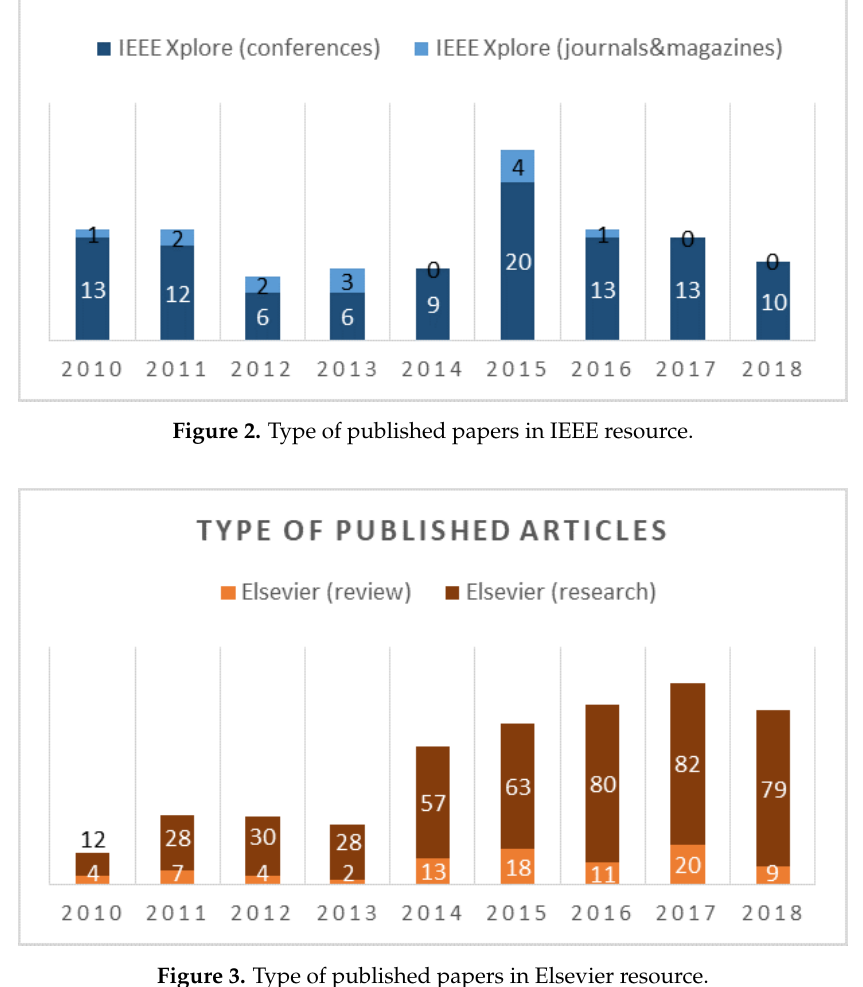
Figure 3. Type of published papers in Elsevier